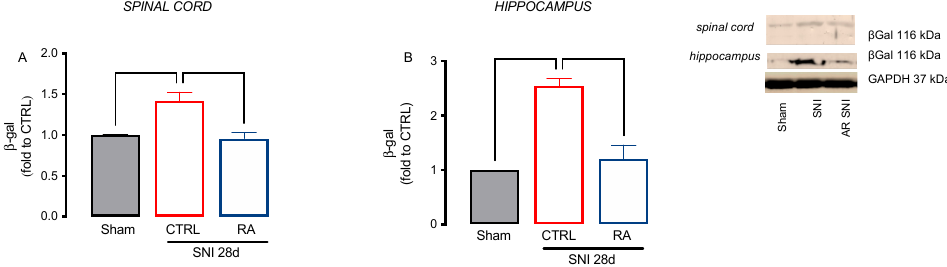
Figure 5. Effect of RA on ß-gal expression. β -galactosidase (ß-gal) protein expression in spinal cord tissue ( A ) and hippocampus ( B ) in un-operated mice (Sham), mice with neuropathy (SNI), and mice with neuropathy treated with rosmarinic acid (RA) 5 mg/kg after 28 days from surgery. Representative blots are reported, loading sample individually.